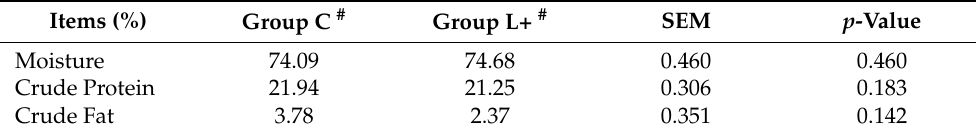
Table 3. Effects of the nocturnal 1-h lighting on the breast meat composition of male mule ducks. Items (%)